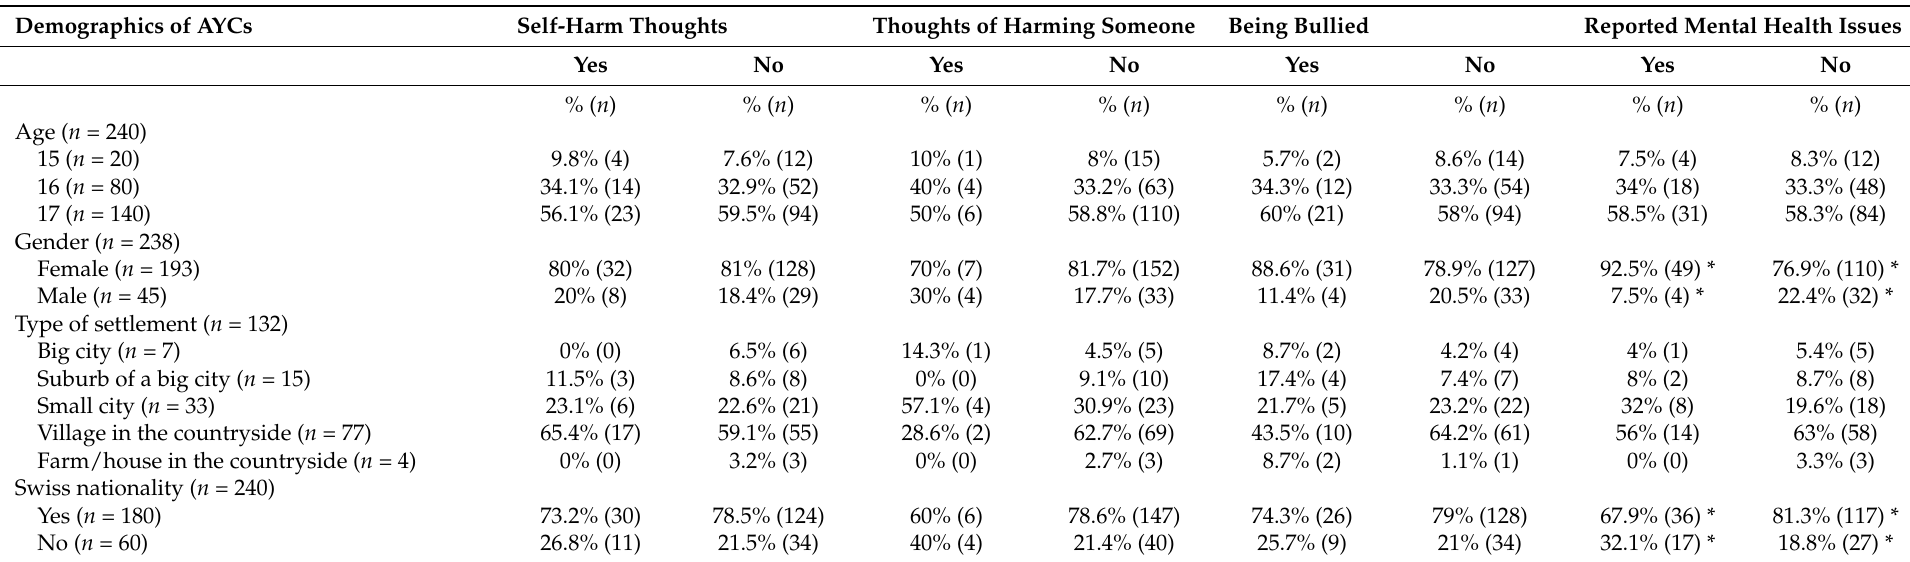
Table 3. Self-harm thoughts, thoughts of harming someone, being bullied, and the reported mental health issues by the demographics. Demographics of AYCs Self-Harm Thoughts Thoughts of Harming Someone Being Bullied Reported Mental Health